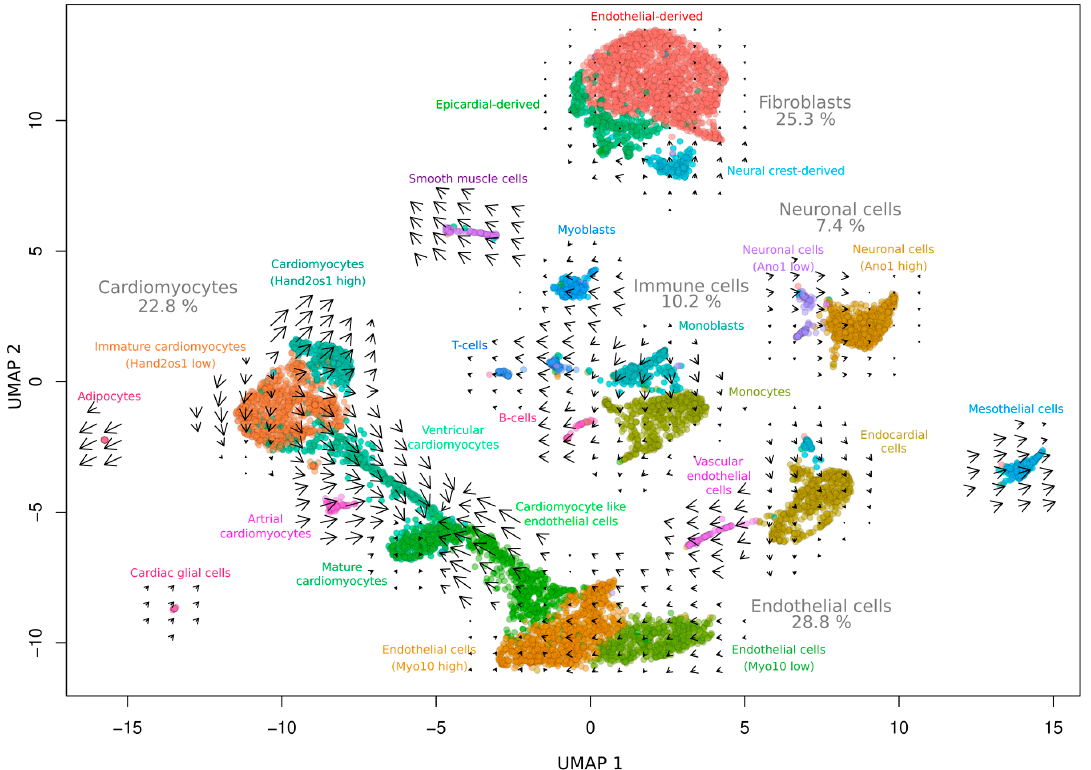
Figure 1. Single-nucleus transcriptome characteristics of pooled whole Fzt:DU mice hearts ( n = 4). UMAP clustering of snRNA-seq data (8635 nuclei) reveals 24 distinct clusters for the indicated cell types. The arrows represent RNA velocity kinetics visualizing the direction and acceleration between mature and nascent mRNA. The percentages represent the nuclei ratio.